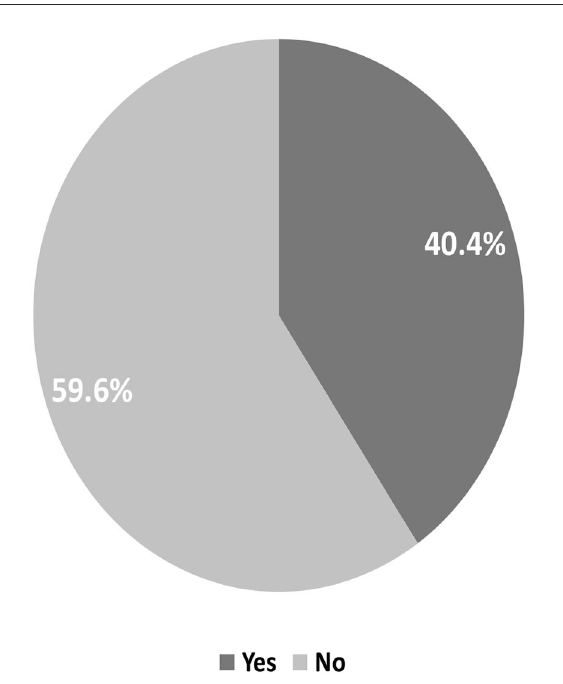
FIGURE2 Magnitude of anxiety among cancer patients’ participants at TASH in Addis Ababa Ethiopia,